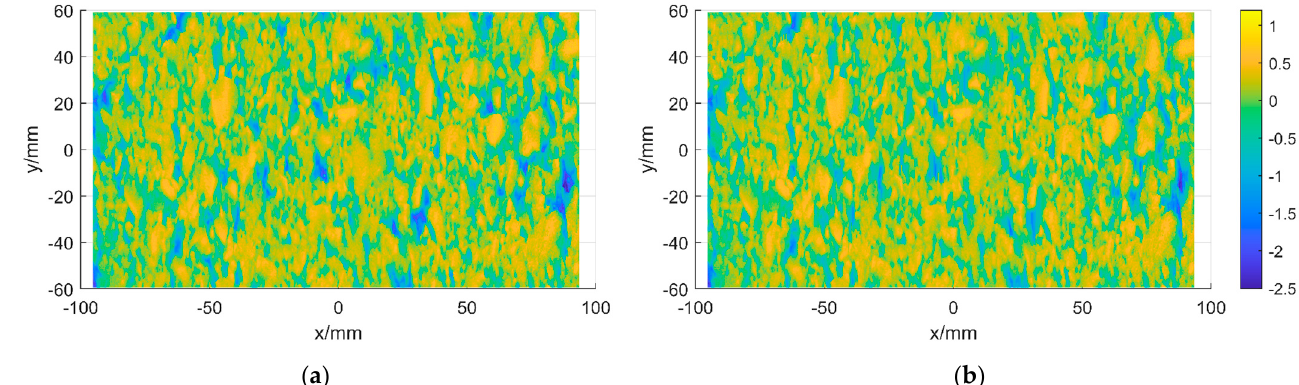
Figure 4. OP of pavement texture. ( a ) Pavement texture before OP. ( b ) Pavement texture after OP.